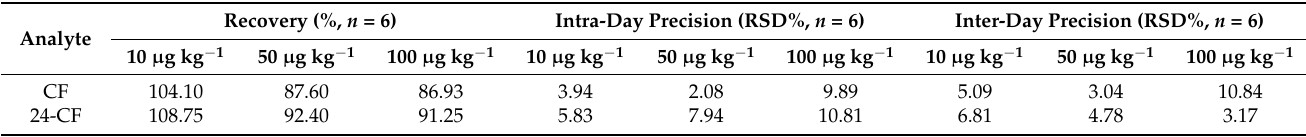
Table 2. Recoveries and precisions for the determination of CF and 24-CF in rice